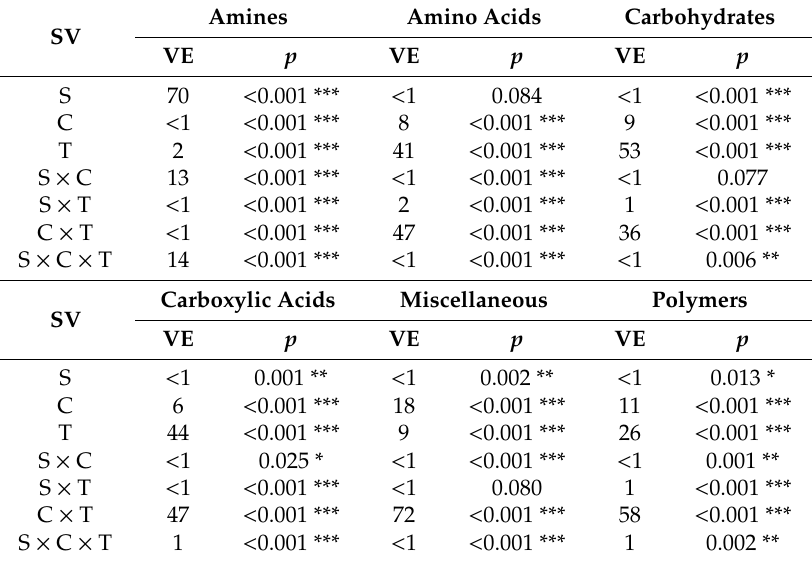
Table 2. Results of the three-way ANOVA for the carbon substrate groups.